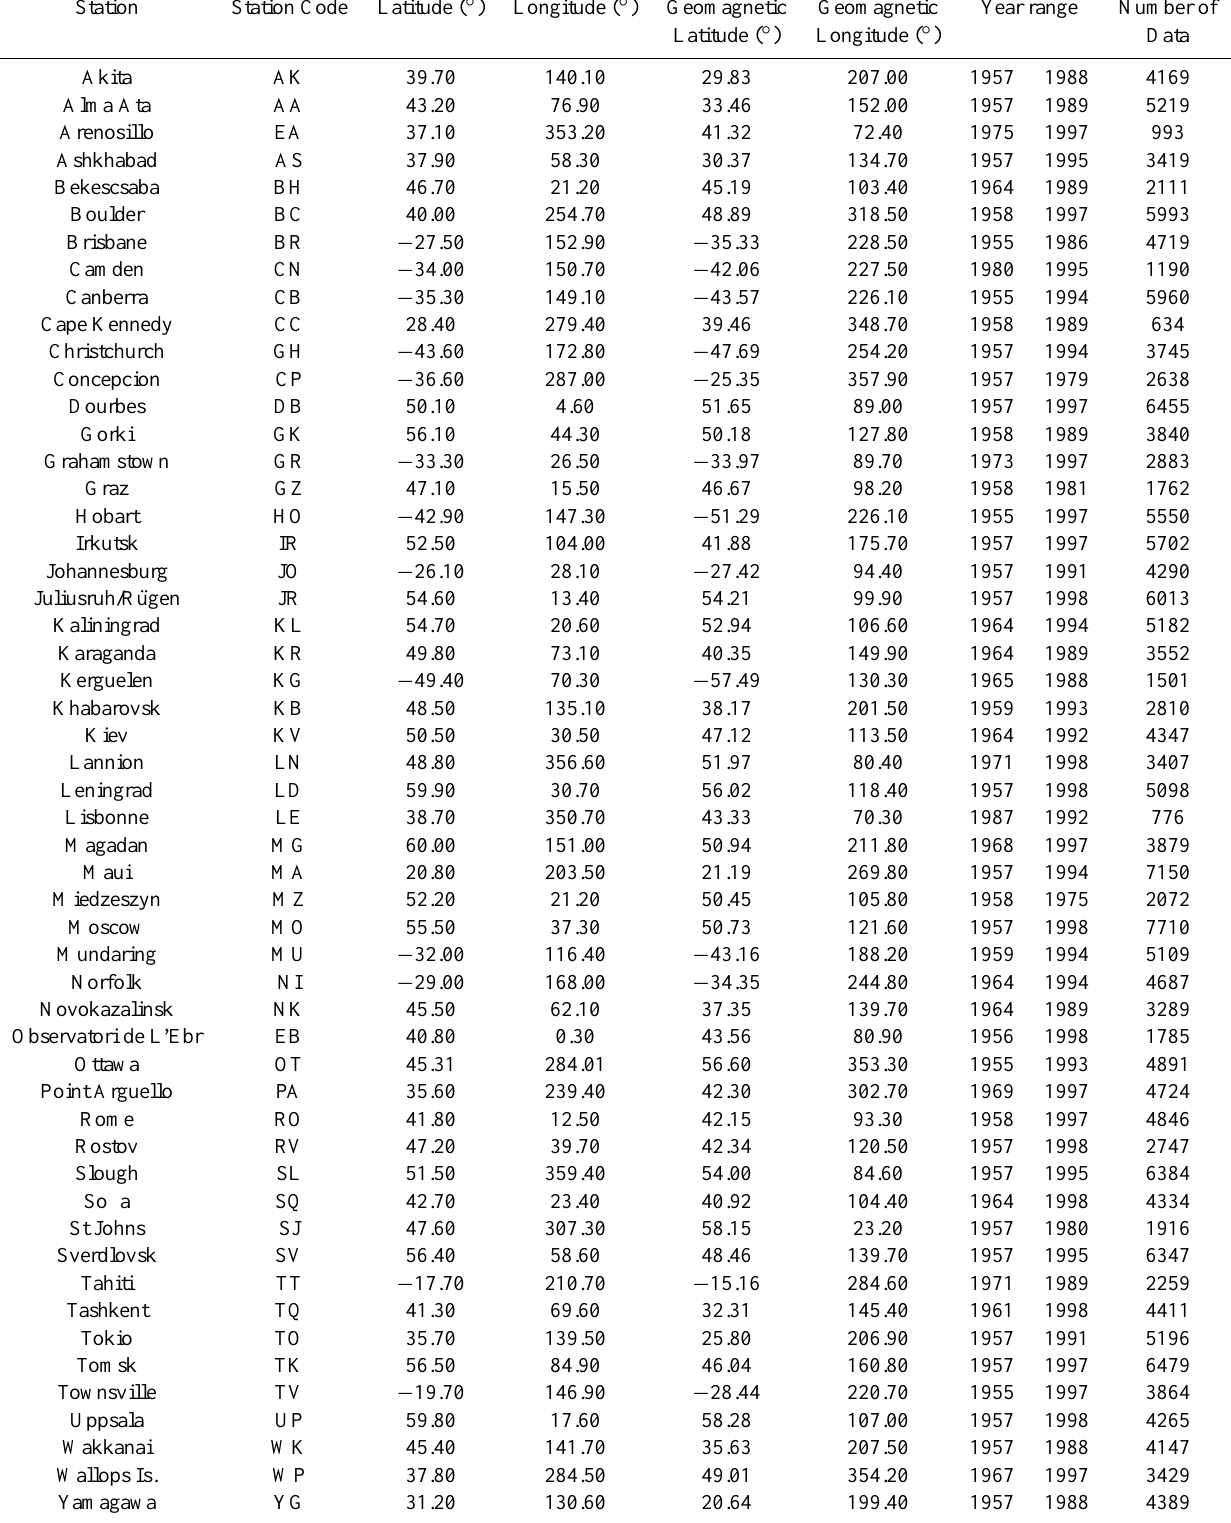
Table 1. List of stations and data samples used in alphabetical